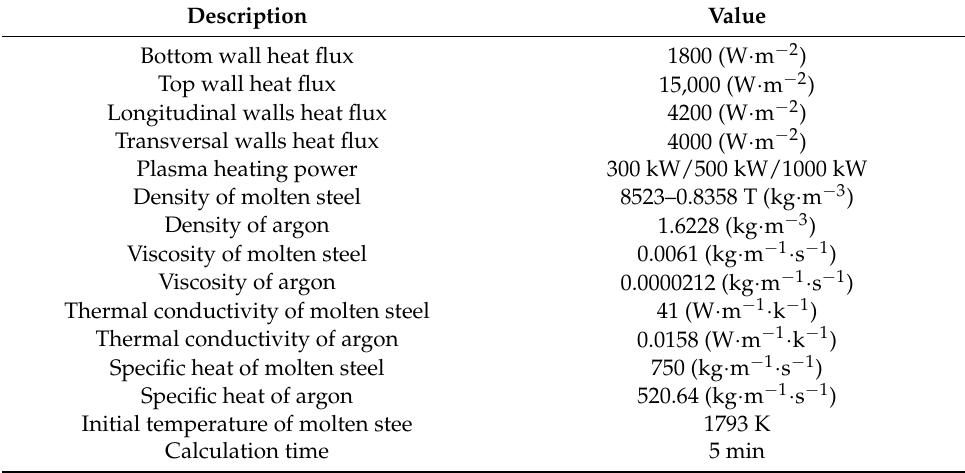
Table 2. Boundary